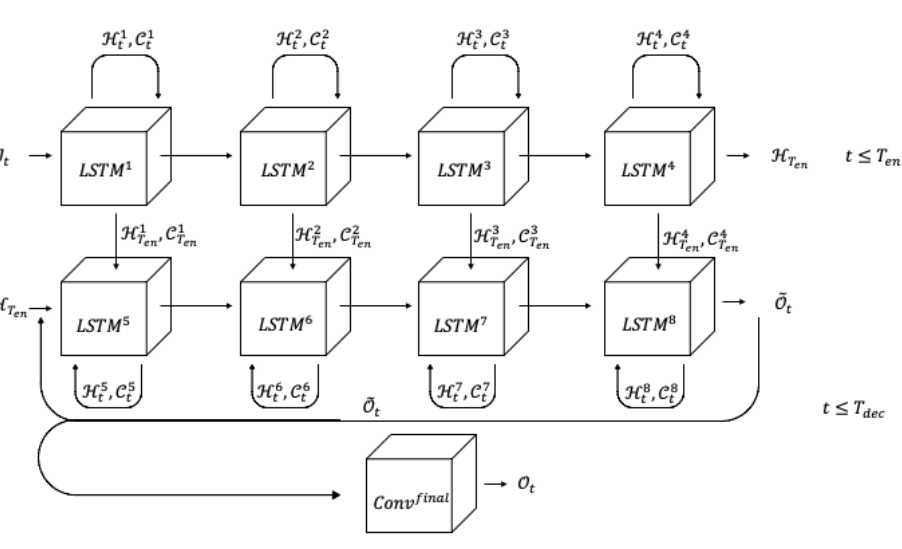
Figure 3. Autoencoder architecture N LSTM of Example